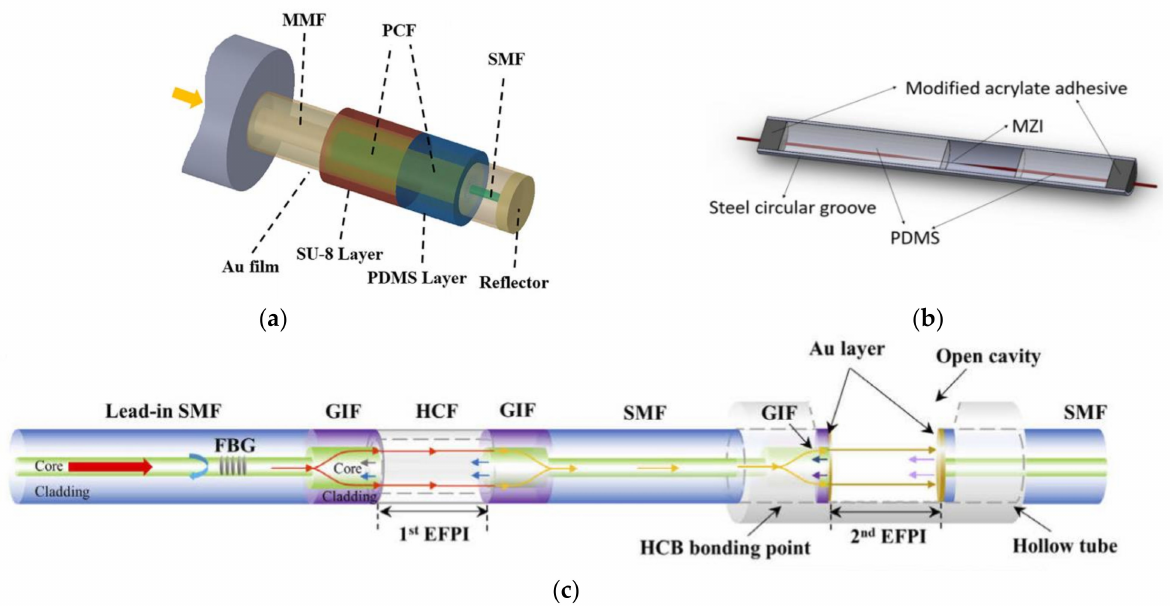
Figure 6. ( a ) Schematic diagram of an SPR-based OFS [121]. ( b ) Schematic diagram of the all- encapsulated and semi-encapsulated MMZI [123]. ( c ) Diagram of the cascaded MZI with SF [125].